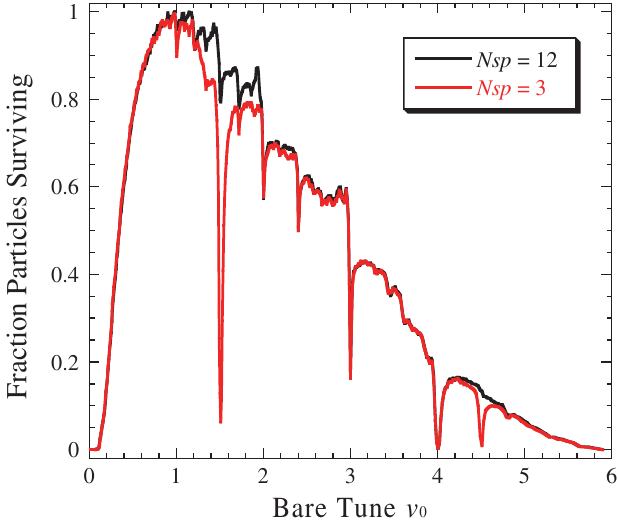
FIG. 5. (Color) Results of 3D tracking simulations without space charge. The number of Ar ions surviving after a 10 msec storage time in the IS is plotted as a function of the one-turn bare betatron tune (cid:4) 0 . The ion number has been normalized with its peak value. The black and red curves show results for no perturbation ( N sp ¼ 12 , upper waveform in Fig. 4) and a three- fold symmetric perturbation ( N sp ¼ 3 , middle waveform in Fig. 4) added to the primary wave. The amplitude of the perturbation is 0.3% of the primary wave. A representative sample of displacement misalignments of the quadrupole elec- trodes has been incorporated in the